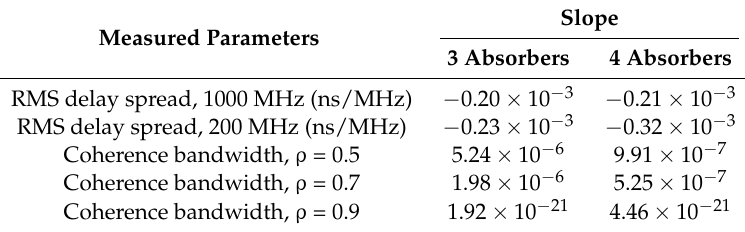
Table 3. Slopes for RMS (root-mean-square) delay spread and coherence bandwidth in the NIM (National Institute of Metrology) RC (reverberation